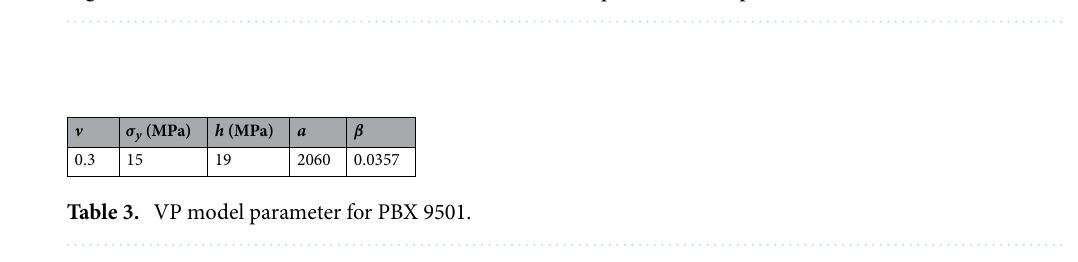
Figure 3. The stress–strain curves for PBX 9501 under the quasi-static compressive tests.